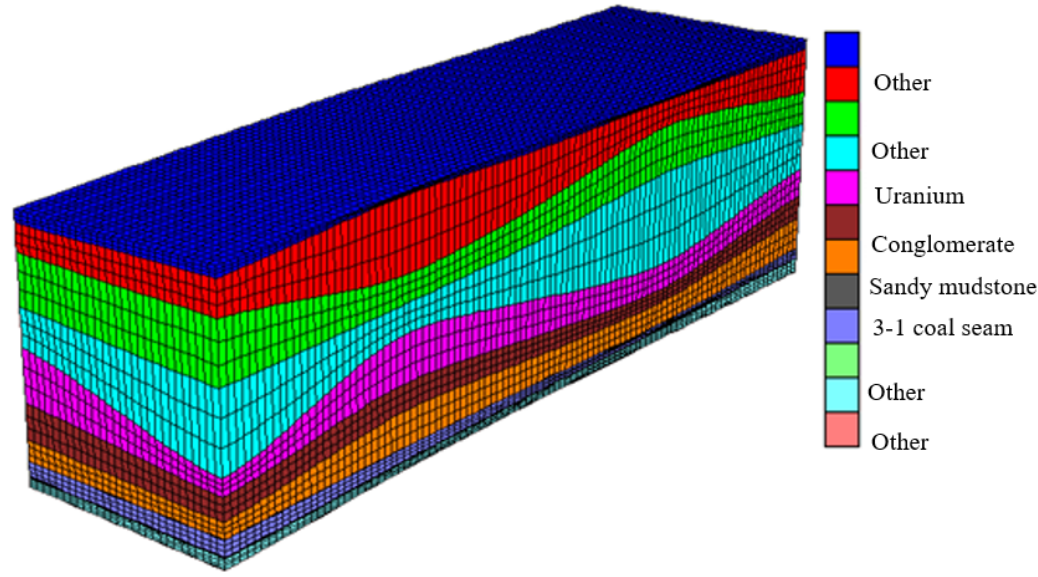
Figure 2. Hydrogeology model.